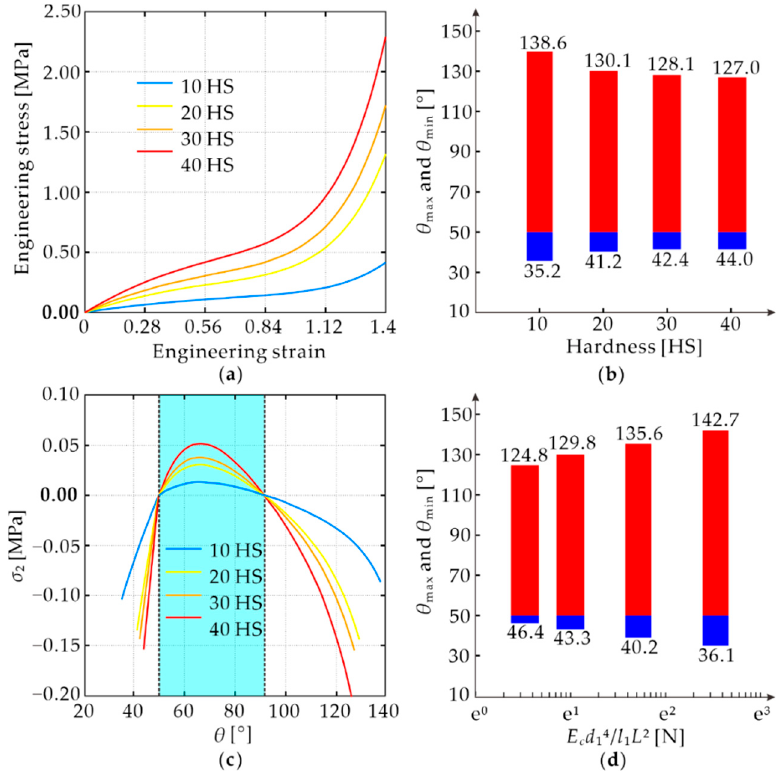
Figure 10. ( a ) Material properties of the rubbers with different hardness; ( b ) effects of rubber hard- ness; ( c ) minimal principal stress at different hardness; ( d ) effects of CFRP reinforcement. Table 5. Material properties of the rubbers with different